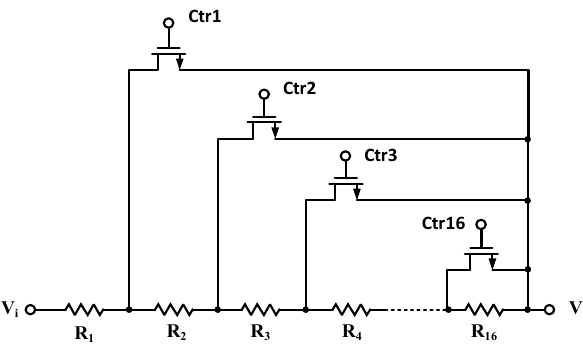
Figure 3. The programmable gain amplifier (PGA).